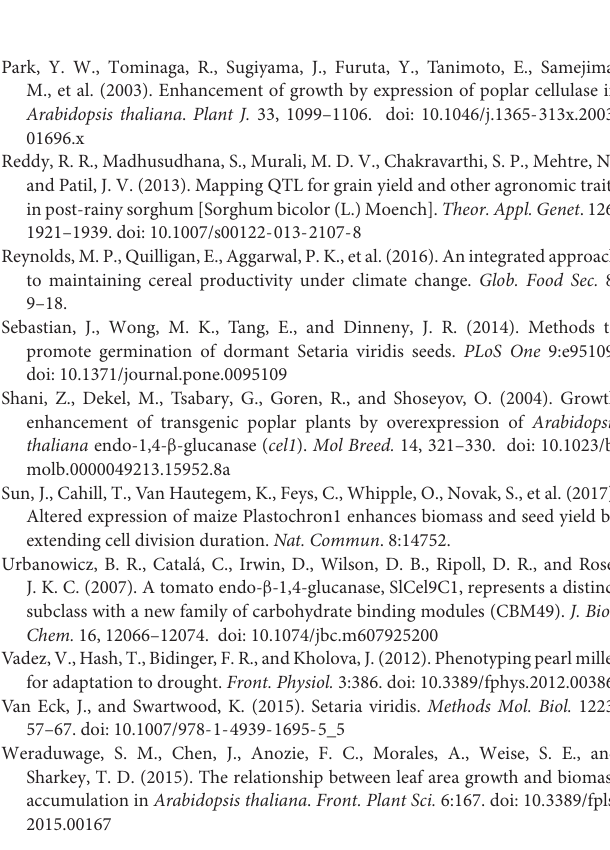
Supplementary Figure 1 | Molecular characterization of T 0 Sicel1 and EVC events showing transgenic nature of the regenerated plants. PCR confirmation of hygromycin phosphotransferase ( hpt ) marker gene in 7 independent transgenic S. viridis Sicel1 (lane 3–9), and 2 empty vector controls (in duplicate, lane 13–16) T 0 events. The pANIC10A vector and no template were used as positive (Lane 2, 10 and 11) and negative (Lane 12) controls, respectively, for the PCR. Lane 1, 1 kb marker DNA. Supplementary Figure 2 | Confirmation of transgene integration. Southern blot analysis confirming T-DNA integration and copy number of the hpt marker gene in S. viridis plants of 1258.7, 1279.3, and 1287.4 T 1 families and empty vector controls. The genomic DNA was digested with Mfe 1 enzyme and probed with DIG labeled hpt